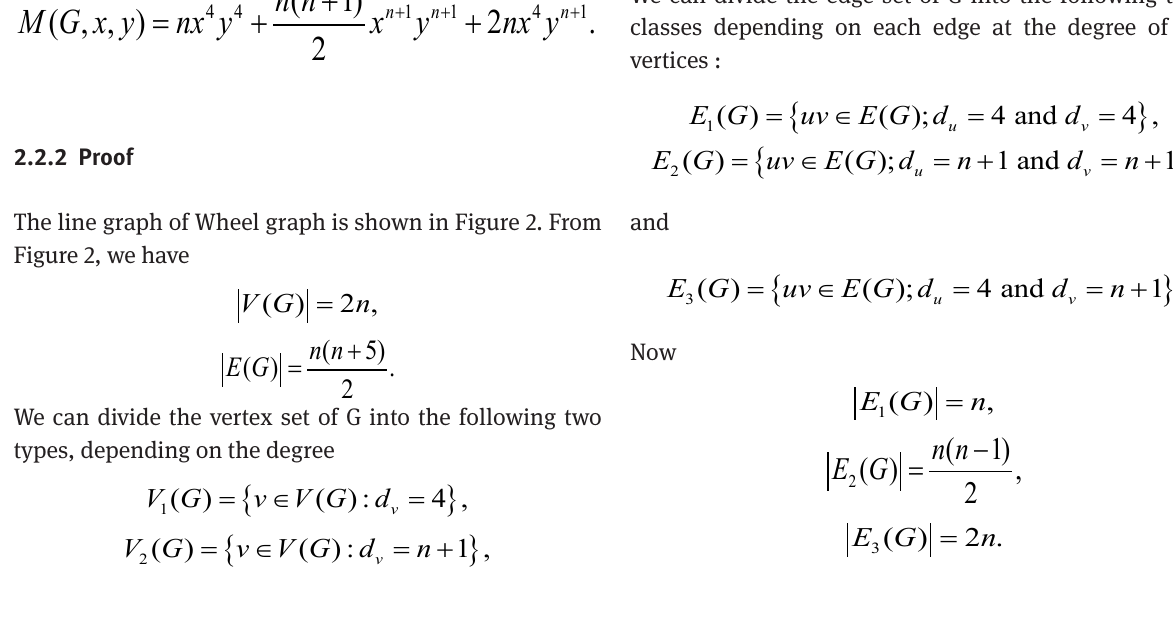
Figure 2: Line graph of Wheel